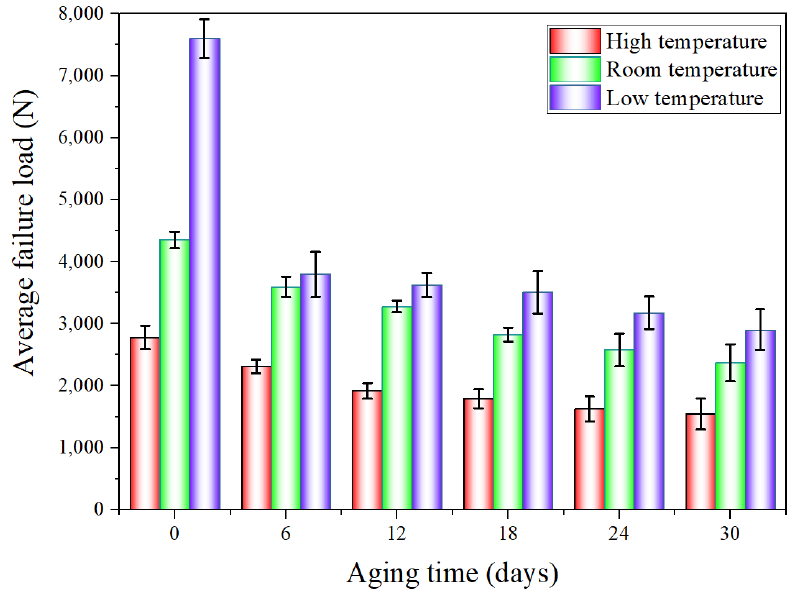
Figure 6. The average failure load of BJs after hygrothermal aging at different temperatures.